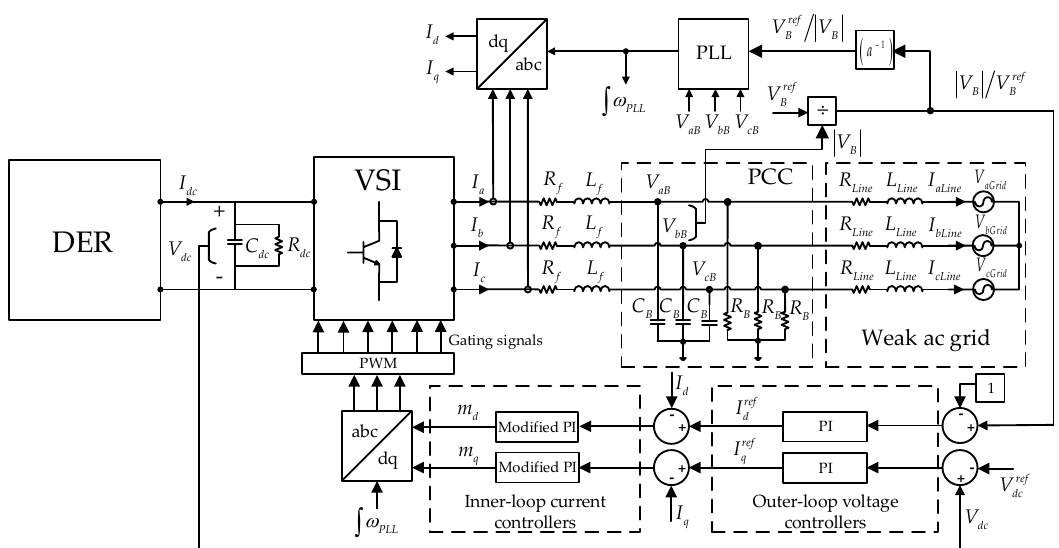
Figure 1. Overall power and control block diagram of the system under consideration.